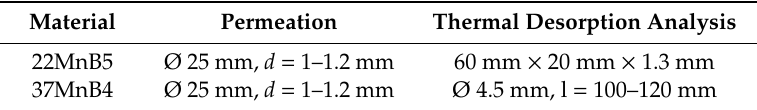
Table 3. Dimensions of the sample.